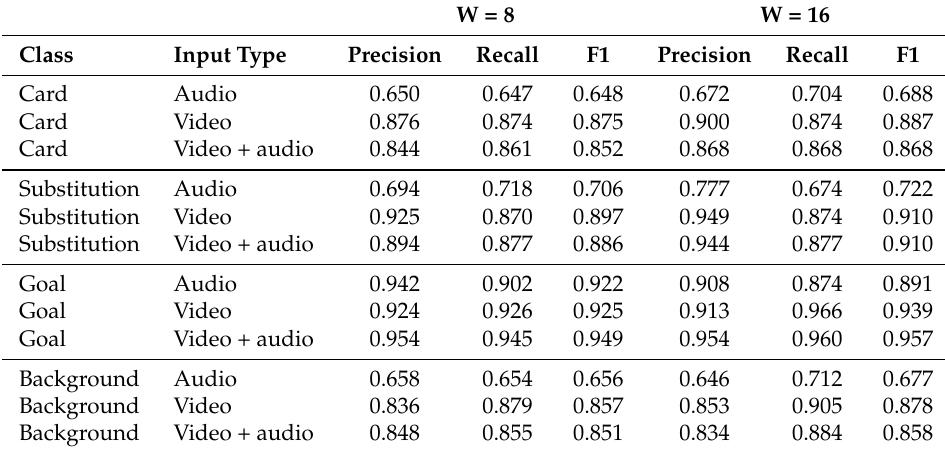
Table 6. Comparison of precision, recall and F1-score per class (event type), for the 3D model (Section 3.2). W is the window size used for the input. The results for the combined input types are obtained using late fusion with softmax average.